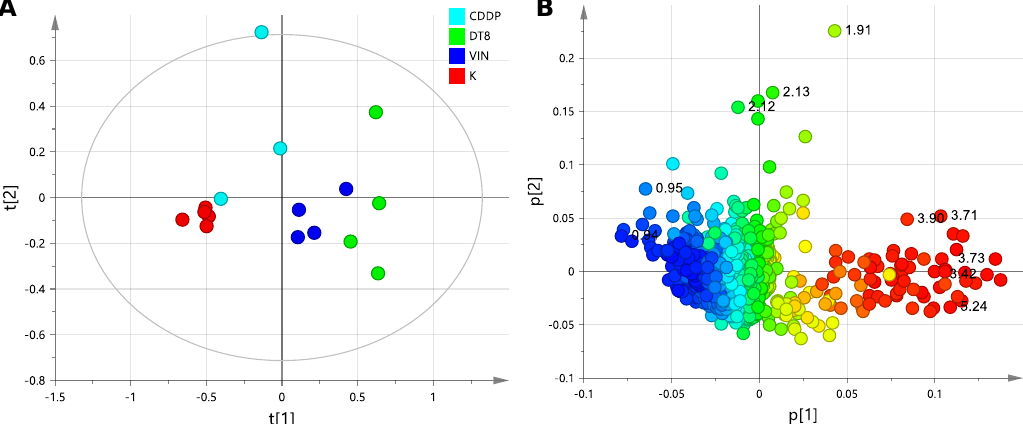
Figure 3. Principal component analysis, PCA score plot ( A ) for the whole data and corresponding color-coded coefficient loading plot ( B ) derived from the 1 H-NMR spectra of cell lysate obtained from different groups. K: controls; CDDP: cis-platin, DT8: DT-8 treatment, VIN: vinblastine. The outer ellipse represents the 95% confidence interval (T 2 Hotelling). Variables are the loadings, colored according to the absolute value of the correlation loading, p [1].